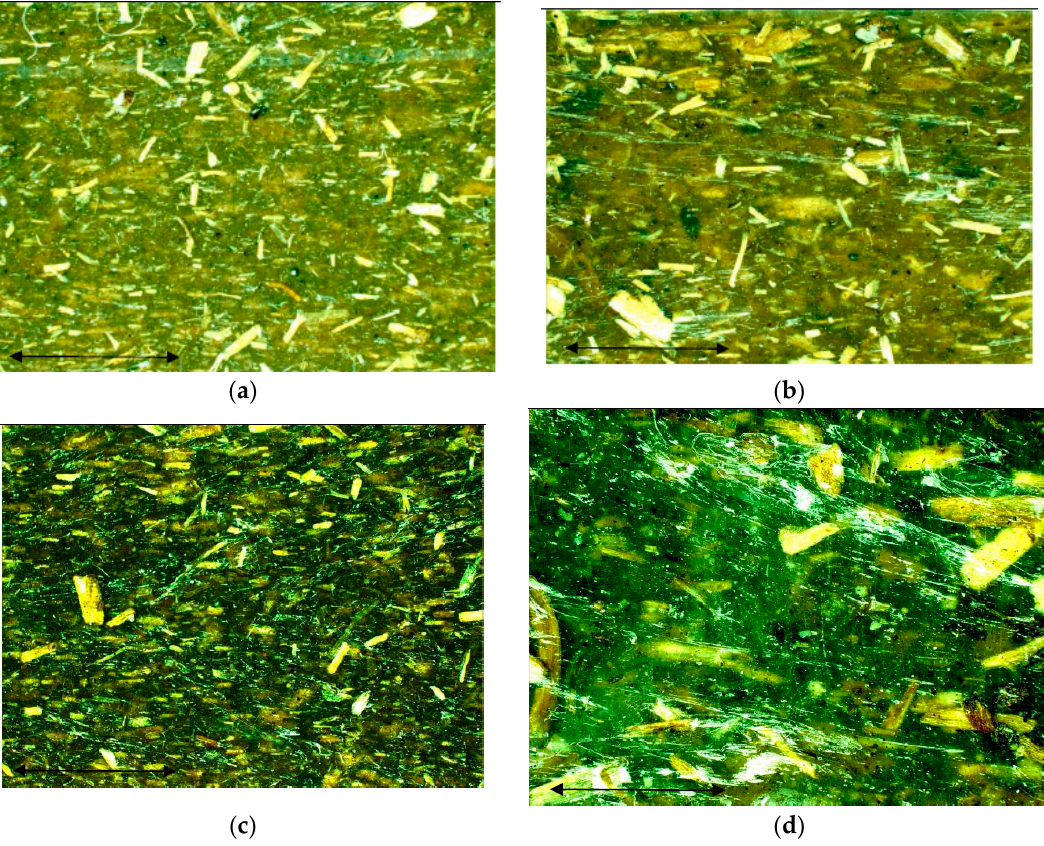
Figure 7. Surface microscopy images of HPP composite with 15% loading of date palm fiber (DPF). ( a ) Untreated powder; ( b ) untreated fiber; ( c ) treated powder; ( d ) treated fiber.